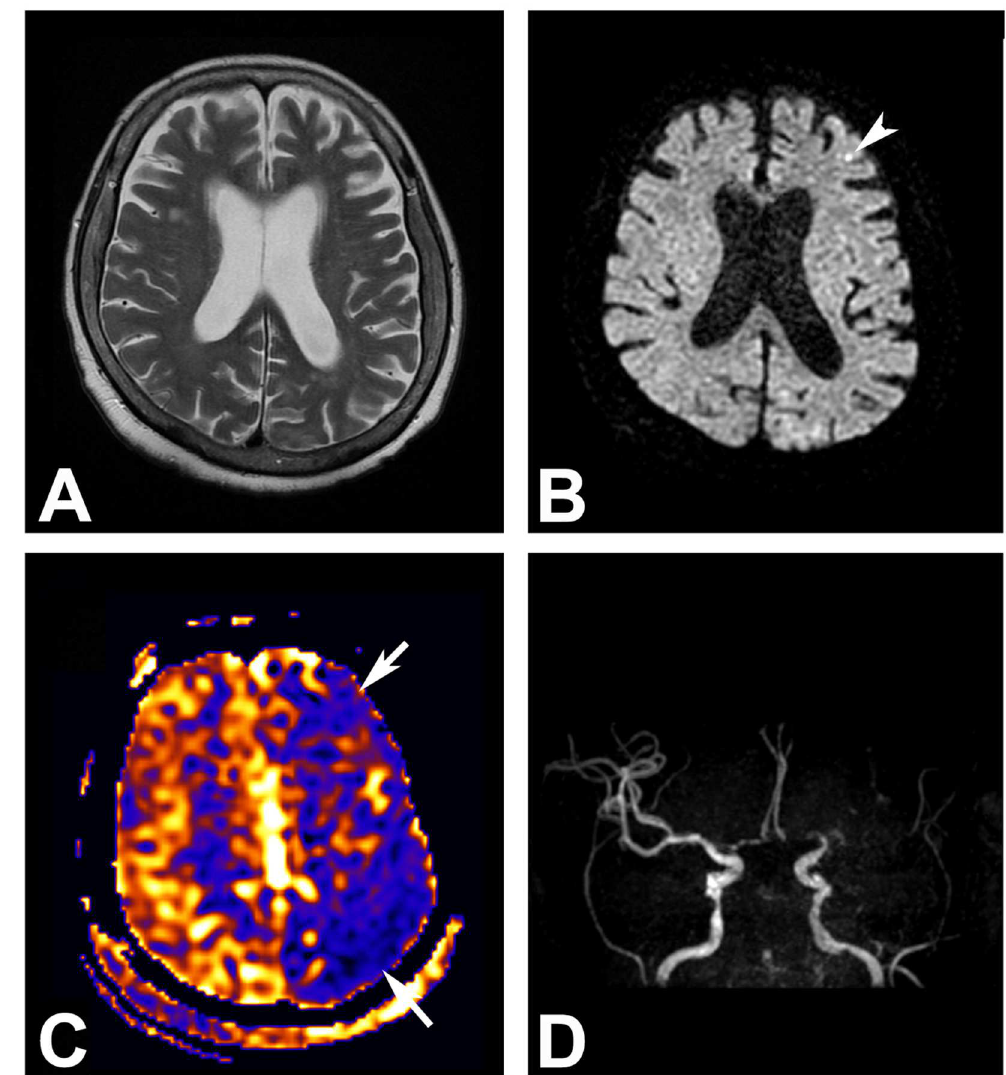
Fig 3. A 87-year-old woman who showed a convulsive seizure in the patient ward. (A) Brain parenchyma appearsnormalon the T2-weighted image. (B) A tiny dot-likediffusion restriction is noted at the left frontal cortex (arrowhead). Subtle cortical hyperintensities at the left occipitallobe are artifacts. (C) Arterial spin labeling perfusion-weightedMR image depicts hypoperfusion at the left middlecerebralartery territory (arrows). (D) MR angiography shows occlusionat the left M1